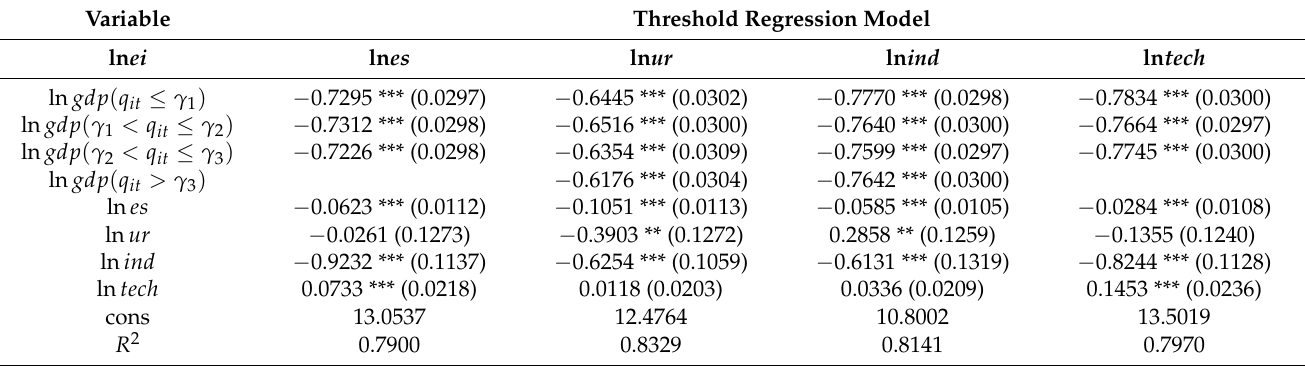
Table 7. Threshold regression estimations of the relations between per capita GDP and energy intensity.